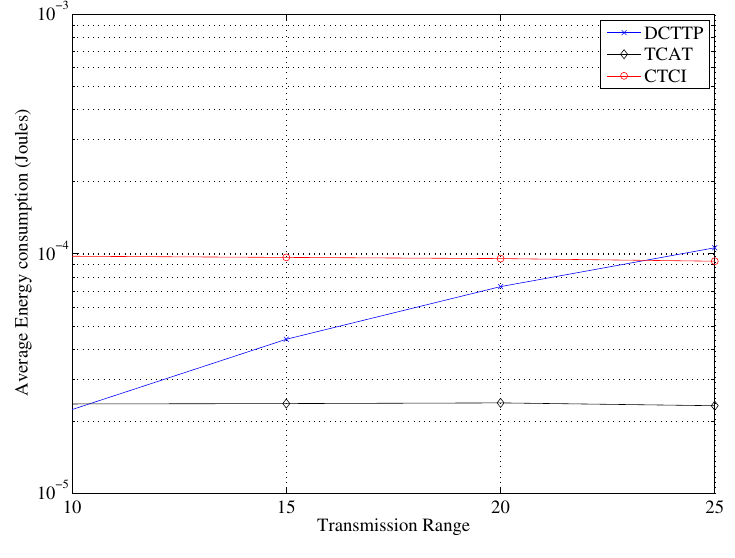
Figure 19. Impact of the transmission range on the average energy consumption.